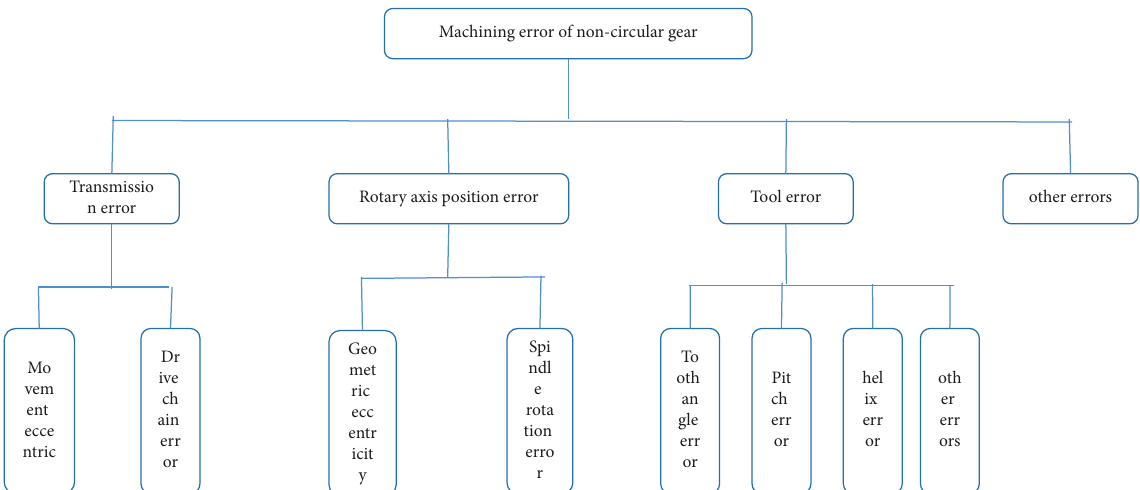
Figure 3: Classification according to the nature of the